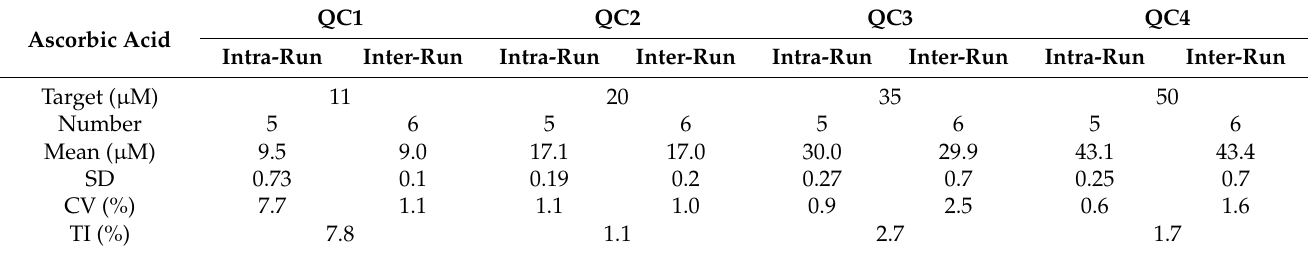
Table 1. Precision test with intra- and inter-assay variation for AA measurement with HPLC. Target ( µ M) is the required concentration of the quality control samples (QC1, QC2, QC3, QC4). SD is the standard deviation. CV is the ratio of the standard deviation to the mean. TI is the total imprecision.